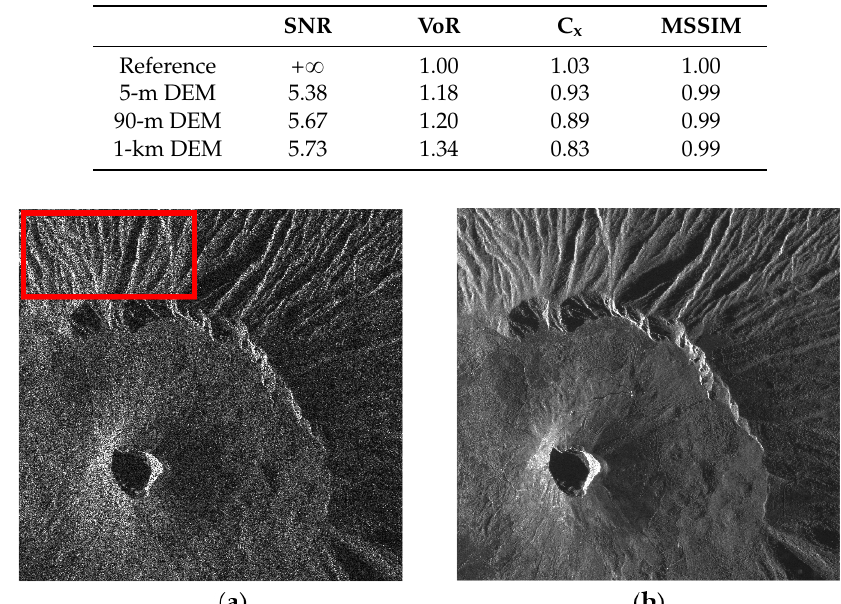
Table 4. Performance parameters of SB-SARBM3D in the actual